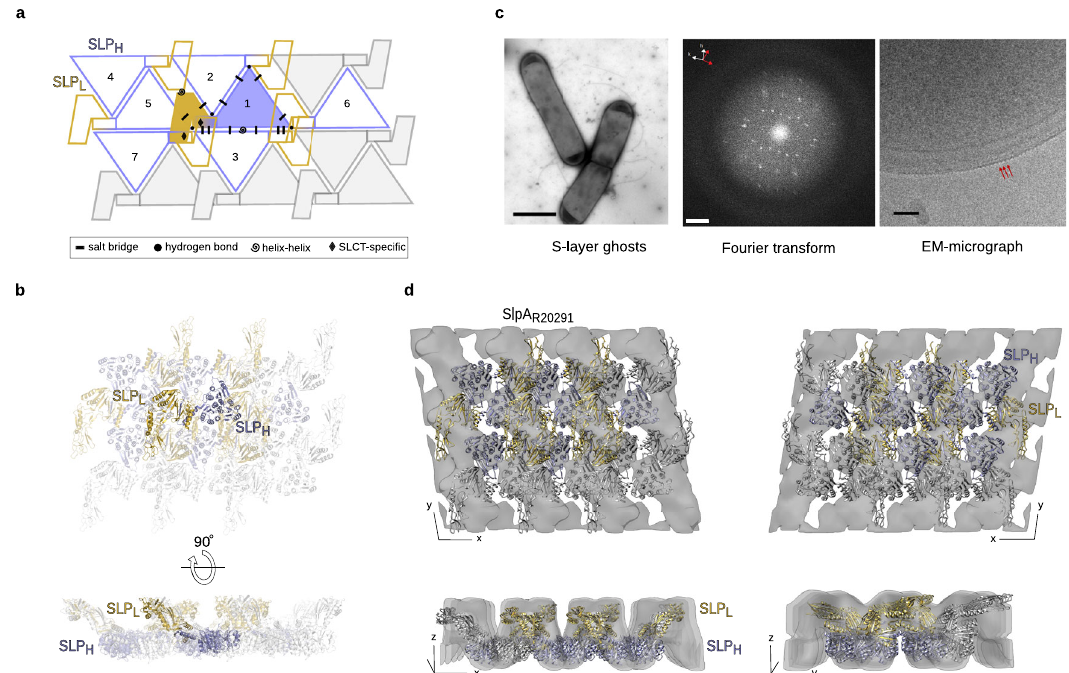
Fig. 3 Planar crystal packing in the X-ray structure fi ts the in situ packing of the native S-layer. a 2D schematic of H/L complex crystal packing, indicating the interaction network linking a single H/L (slate blue/gold) complex with six other molecules in a planar arrangement generated by SLP H tiling. Array is depicted as seen from the extracellular environment, with symbols representing key interaction types in the crystal lattice, detailed in Supplementary Fig. 4. b Cartoon representation of the H/L planar array (PDB ID 7ACY, coloured as in a , views as de fi ned in Fig. 1b). c Native C. dif fi cile S-layer ghosts (electron micrograph, negatively stained, left. Scale bar: 2 µ m) were used to compute Fourier transforms (middle). Micrograph is a lower magni fi cation (×3000) of ghosts used to collect the images used (82351x) for Fourier transform computation and is representative of the morphology of S-layer ghosts. Typically spots from two or more lattices were observed. Fourier transform is representative of 36 images collected for R20291. Reciprocal lattice axes (red and white axes) are indicated for two observed lattices (scale bar 0.0125 Å − 1 ). Intact frozen-hydrated C. dif fi cile cells, examined by cryo- electron microscopy (right), show distinctive ridged surface indicated by red arrows (scale bar 50 nm). Micrograph is representative of whole-cell images, which were not used for data analysis and 2D map calculations. Instead, these were computed from homogenised fragments, as described in the Methods section. d , Orthogonal views of the 3D reconstruction of negatively stained S-layer ghost indicating the overall envelope in the native lattice. A rigid body fi t of the structure of H/L complex determined by X-ray crystallography (PDB ID: 7ACY, cartoon representation, SLP L - gold, SLP H - slate) indicates a similar arrangement in the native S-layer ghosts and crystal packing. Reconstruction is shown from the environment (top left) and cell wall (top right), and side views in the 2D plane (bottom